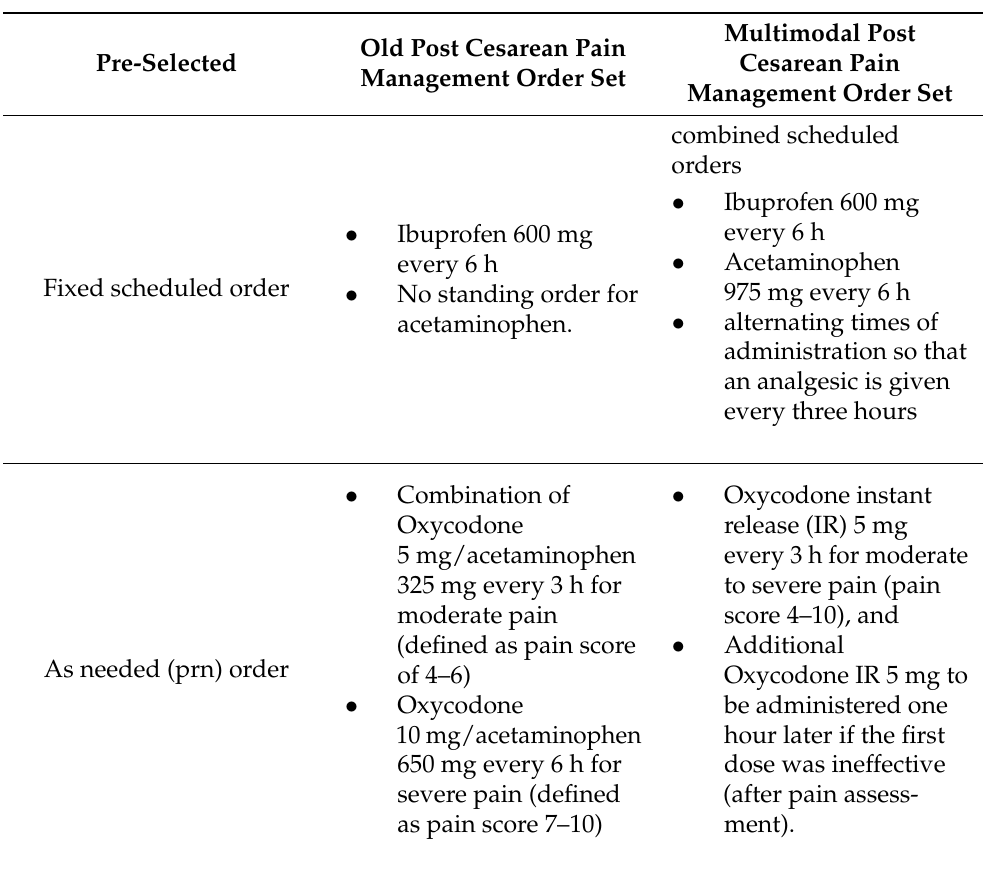
Table 1. Old vs. multimodal post cesarean pain management order